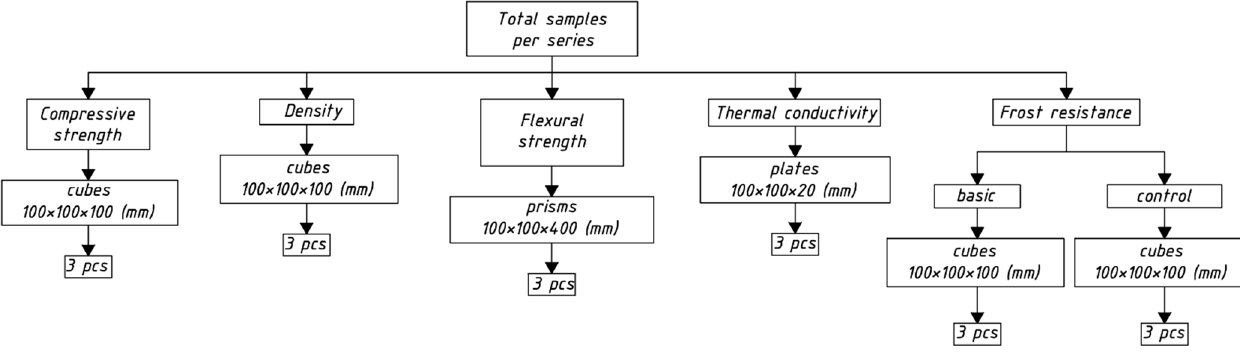
Figure 3. Test research program.